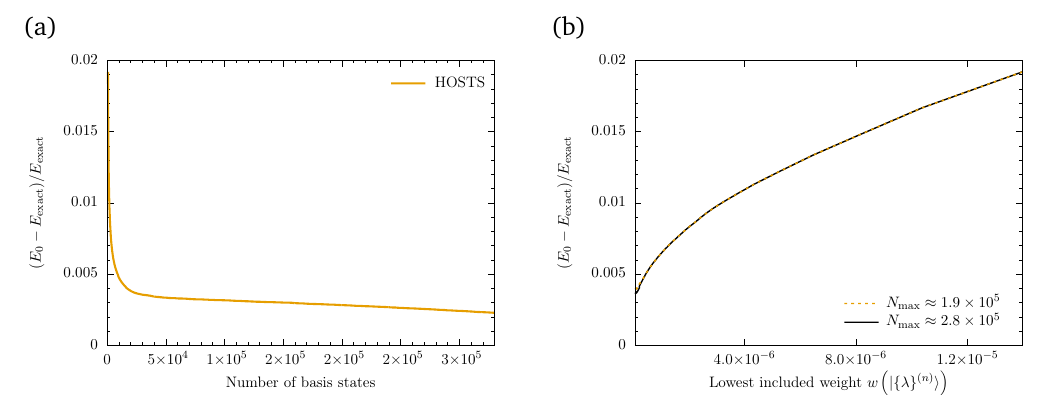
= 20 ground state constructed in Figure 8: The convergence of the energy E of the c i 0 = 10 eigenstates via the numerical renormalization group within the high terms of c f overlap states truncation scheme (HOSTS). (a) E as a function of number of basis 0 ≈ 3.9 × 10 5 states are generated via ABACUS and ordered according states; N max to their weights (22). (b) E as a function of the lowest included weight in the 0 first two hundred steps of the numerical renormalization group procedure for two different total basis sizes, N . In both (a) and (b) the numerical renormalization max + ∆ N = 800 and ∆ N = 160. Convergence group procedure is performed with N s s s of E to under 1% is achieved with only a few thousand basis states, cf. Fig. 4. The 0 convergence w.r.t. the Fermi energy is also smaller than 1% towards the end of the